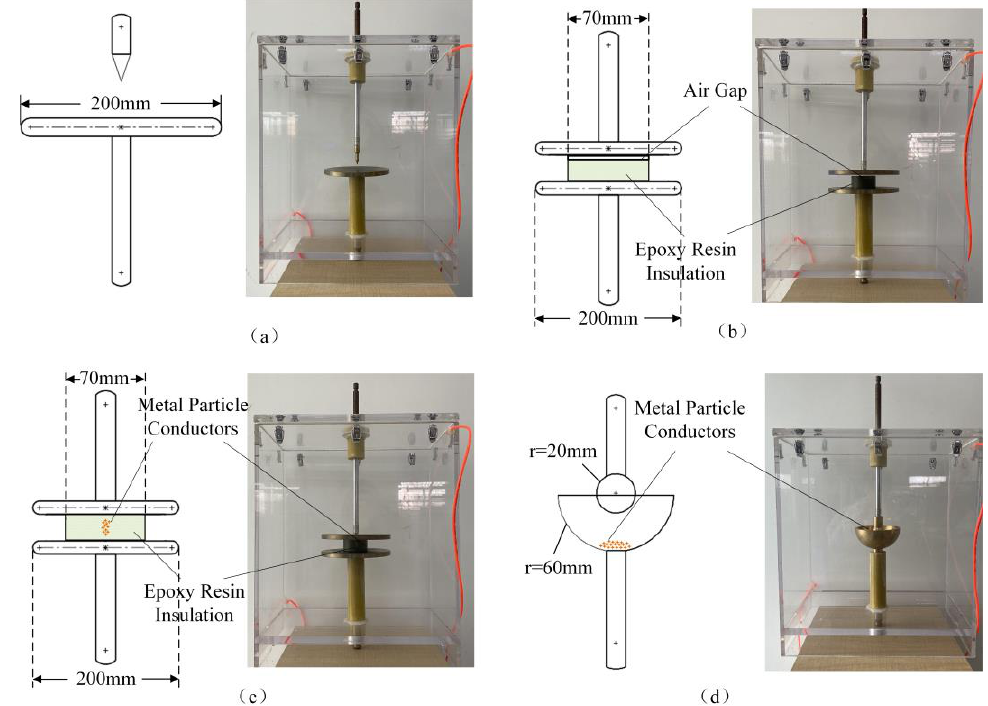
Figure 2. Four types of simulated defects: ( a ) metal protrusion, ( b ) air gap between the metal conductor and the insulator, ( c ) pollution on the insulator surface, and ( d ) charged metal particles.